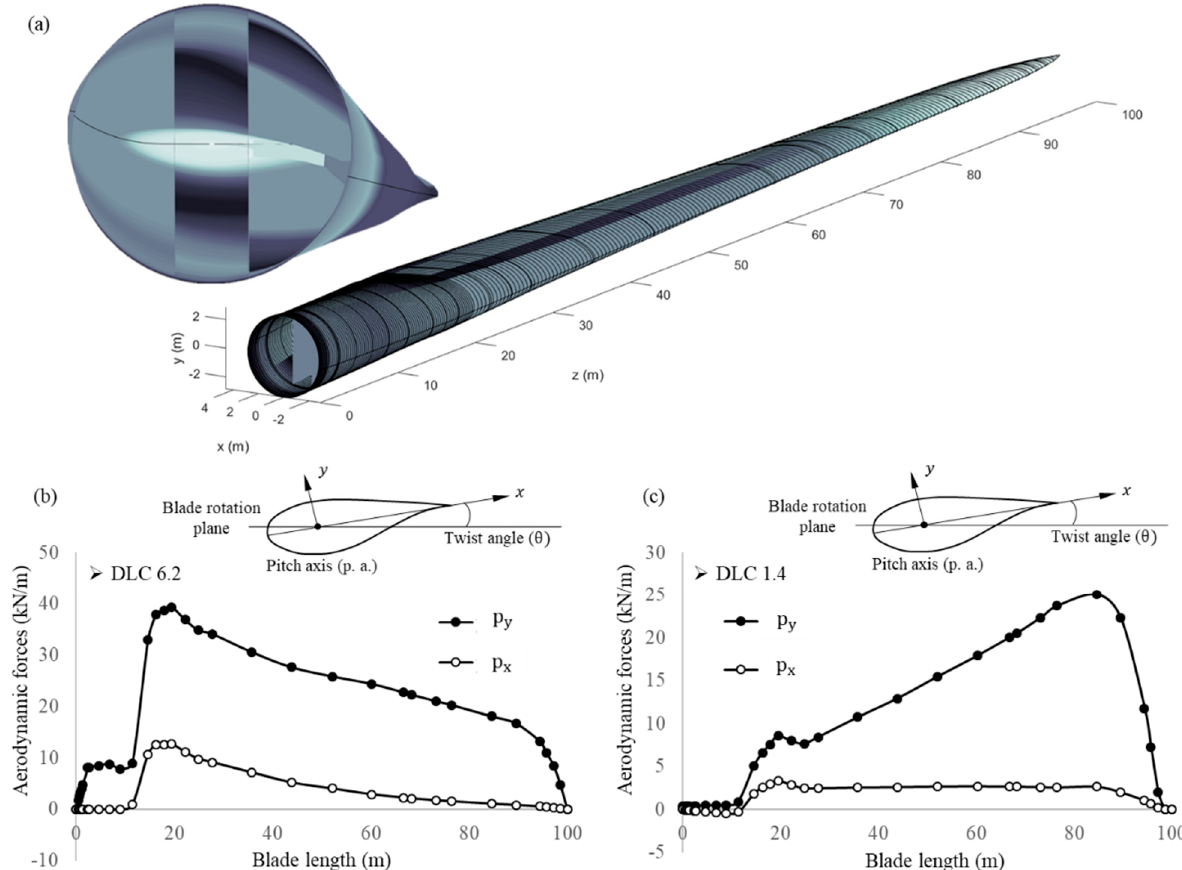
Figure 2. ( a ) SNL blade modelling using Co-Blade, and ( b , c ) computed aerodynamic load distribu- tions for DLCs 6.2 and 1.4. Table 2. Blade model verification for DLC 6.2.